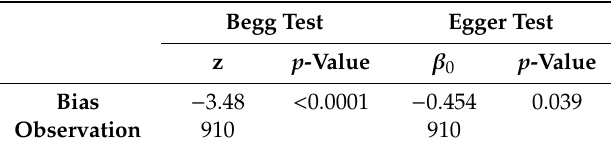
Table 2. Funnel asymmetry test for publication bias.